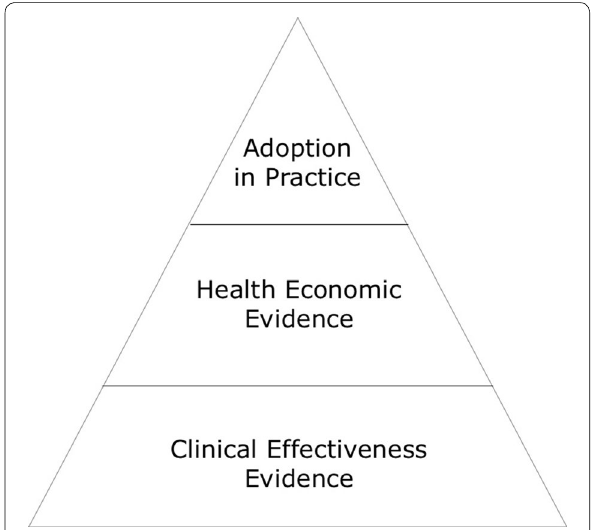
Fig. 1 AIT adoption pyramid for real‑life